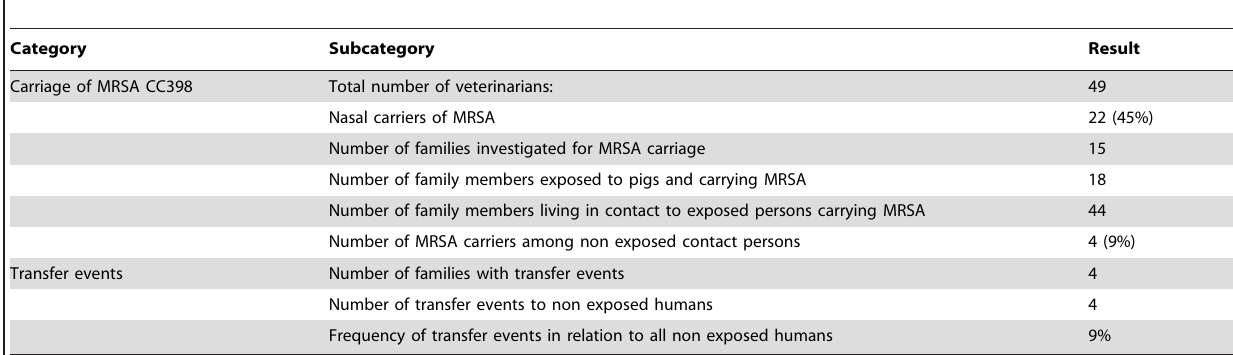
Table 2. Nasal carriage of MRSA CC398 among veterinarians attending pigs and among their family members.